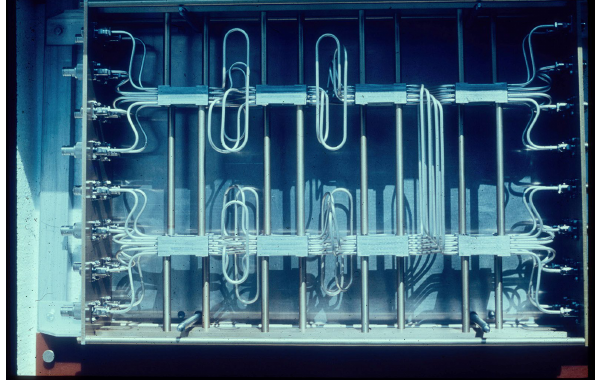
Figure 4. STARE receiver array at the new site in